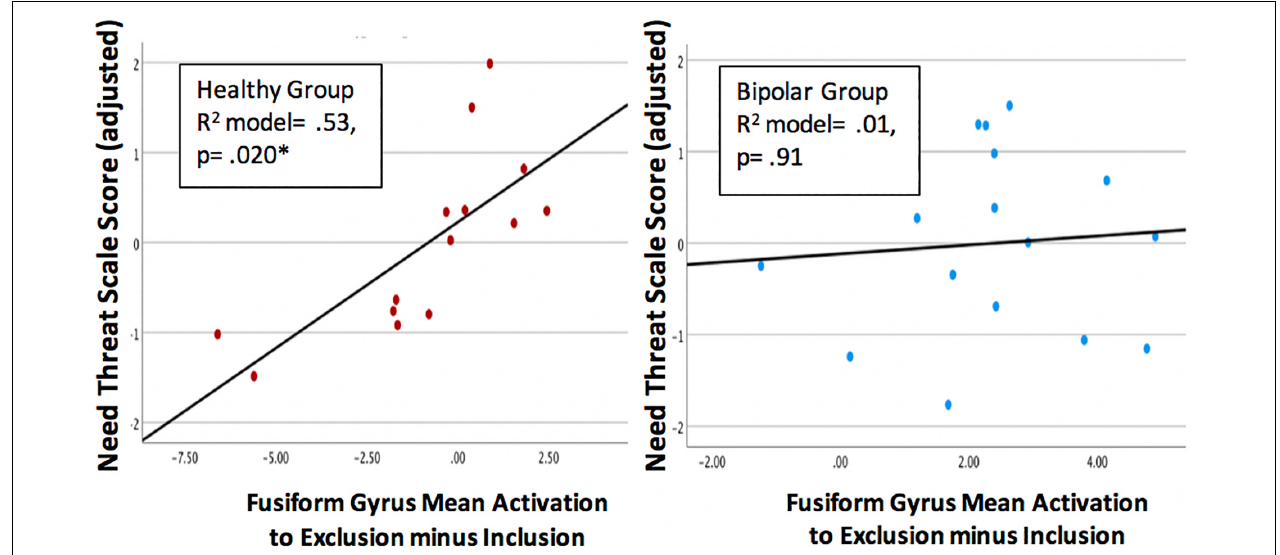
FIGURE 4 | Scatterplots showing the association between activation of the left fusiform gyrus (FFG) and subjective distress during exclusion (Need Threat Scale total score adjusted for age) within the each group. Regression models were significant for the healthy control group ( p = 0.020, left ) but not the bipolar group ( p = 0.91, right